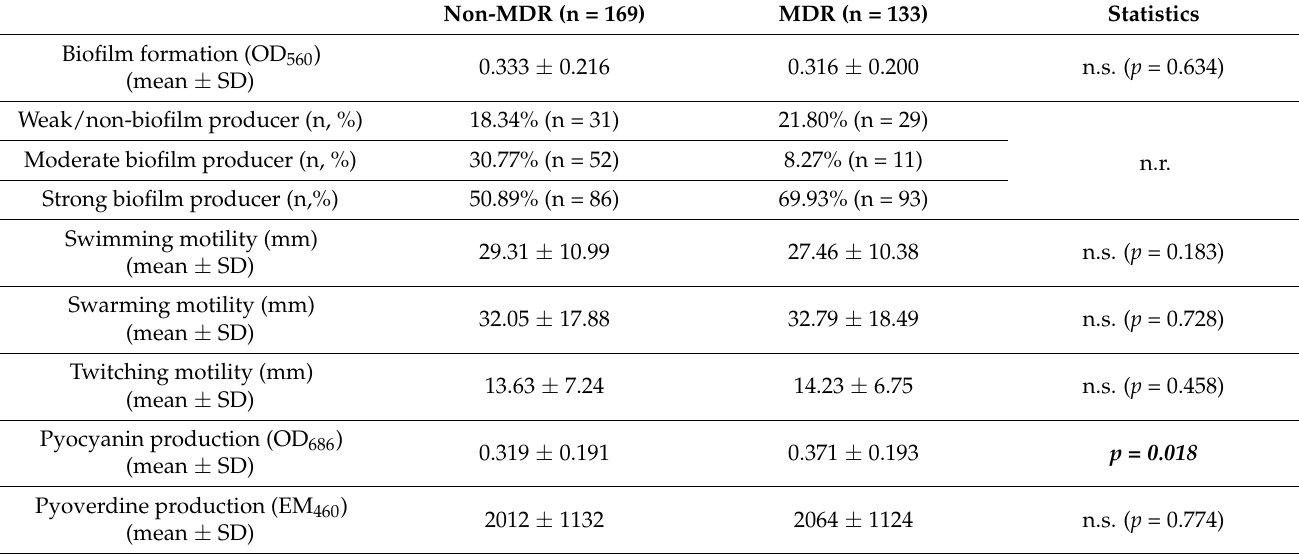
Table 2. Biofilm formation and expression of other virulence factors among non-MDR and MDR P.